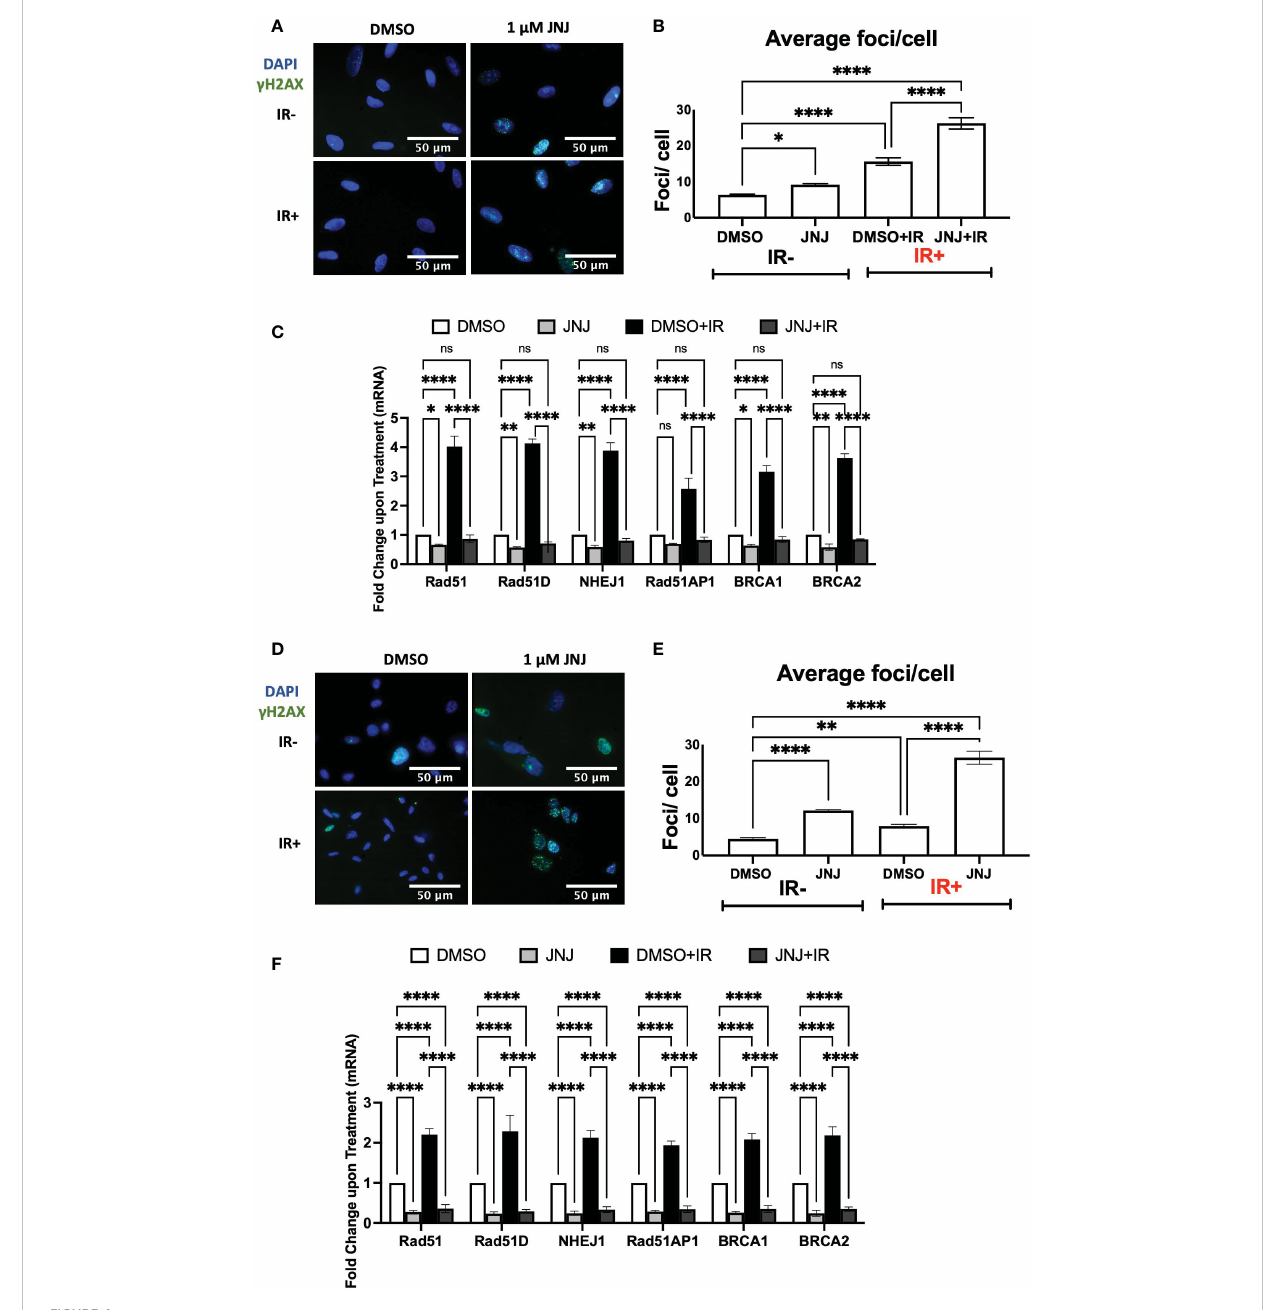
FIGURE 4 JNJ-64619178 inhibits double-strand break repair and DDR genes expression in A549 lung cancer and U87-MG glioblastoma cells. (A) Representative fl uorescence immunocytochemistry images showing double-stranded DNA breaks ( g H2AX foci) images post 6hrs of 2Gy IR in A549 Cells. (B) Quanti fi cation of average DSBs/cells from (A, C) Transcription level change in DDR gene expression as measured by the change in mRNA quanti fi ed by RT-qPCR in A549 cells post 6hrs of 2Gy IR treatment. (D) Representative fl uorescence immunocytochemistry images